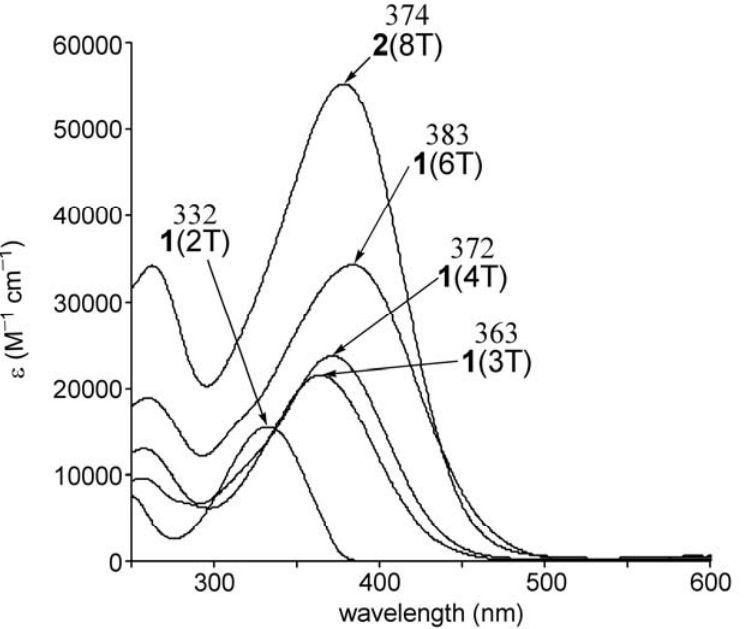
Figure 2. UV-vis spectra of 1 (nT) (n = 2, 3, 4, 6) and